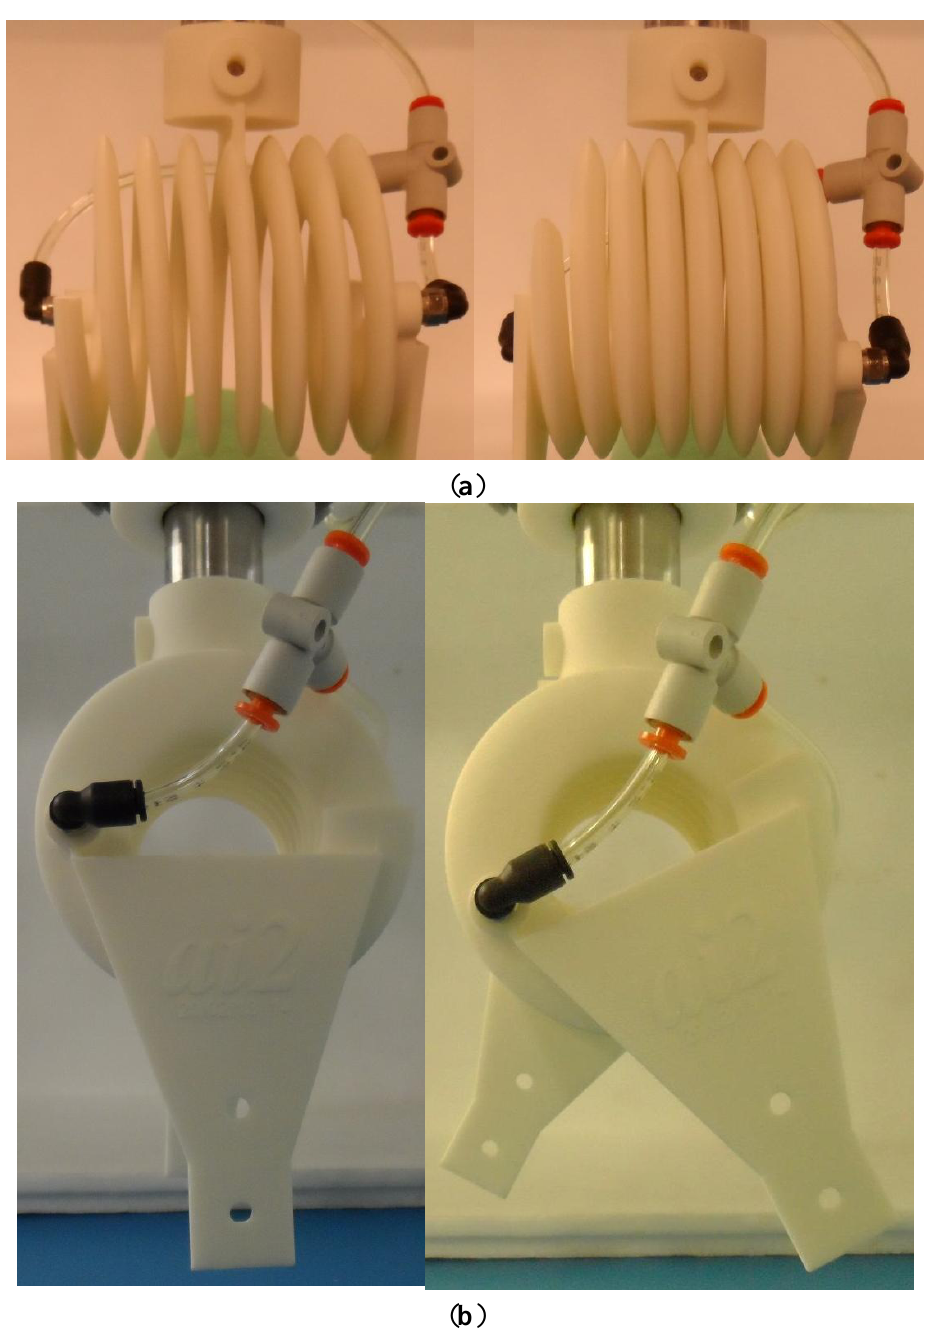
Figure 2. AM actuator with linear contraction motion ( a ) and rotation motion ( b ). Experiment done at 0 and 0.3